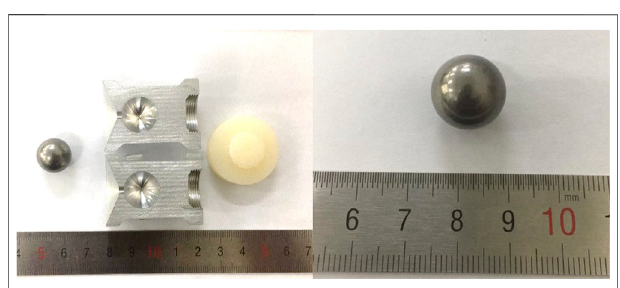
FIGURE 2 | Tungsten alloy fragment and speci fi cally designed